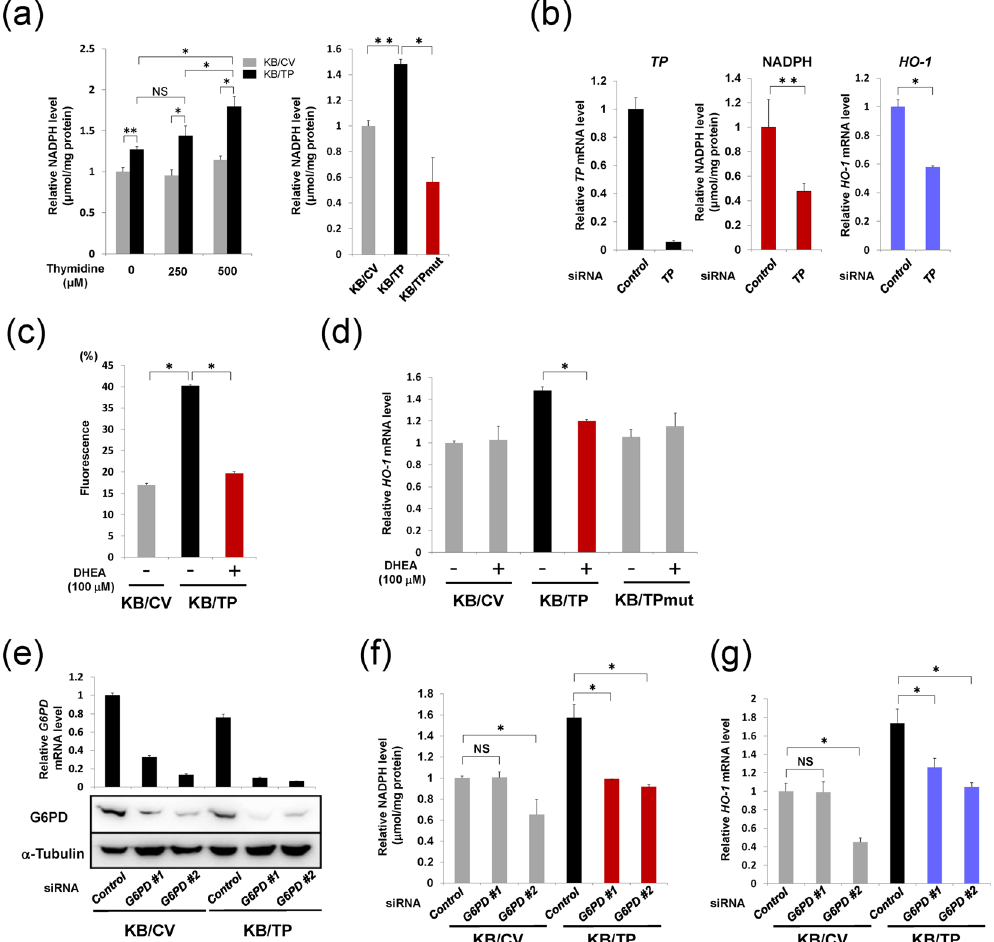
Figure 2. Effect of TP on Intracellular levels of NADPH ( a ) NADPH levels in KB/CV and KB/TP cells incubated in the absence or presence of thymidine at 250 or 500 μ M for 48 h (left). Effect of TP activity on NADPH levels in KB cells. NADPH levels in KB/CV, KB/TP and KB/TPmut cells treated with or without 500 μ M thymidine for 48 h were determined (right). NADPH levels in KB/CV and KB/TP cells were measured using a NADPH assay kit. ( b ) Effect of TP knockdown on TP mRNA (left), NADPH (middle), and HO-1 mRNA (right) levels in Yumoto cells. ( c ) ROS levels in KB/TP cells treated with DHEA for 24 h. ( d ) Expression levels of HO-1 mRNA were determined by real-time PCR in KB/CV, KB/TP, and KB/TPmut cells treated with DHEA for 48 h. ( e ) KB cells were transfected with G6PD siRNA or negative control siRNA. The levels of G6PD mRNA (upper) and G6PD protein (lower) were determined by real-time PCR and immunoblotting, respectively. ( f ) Effect of downregulation of G6PD on NADPH levels in KB cells. KB cells transfected with G6PD siRNAs were treated with 500 μ M thymidine for 48 h, and NADPH intracellular levels were determined. ( g ) Effect of downregulation of G6PD on HO-1 mRNA levels in KB cells. Data are presented as mean ± SD. ∗ P < 0.01, ∗∗ P <